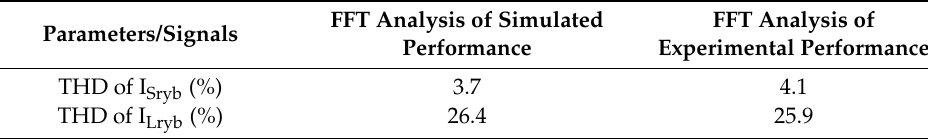
Figure 17. Supply currents of the three phases and their THD. Table 3. THD of the simulated and experimented models.